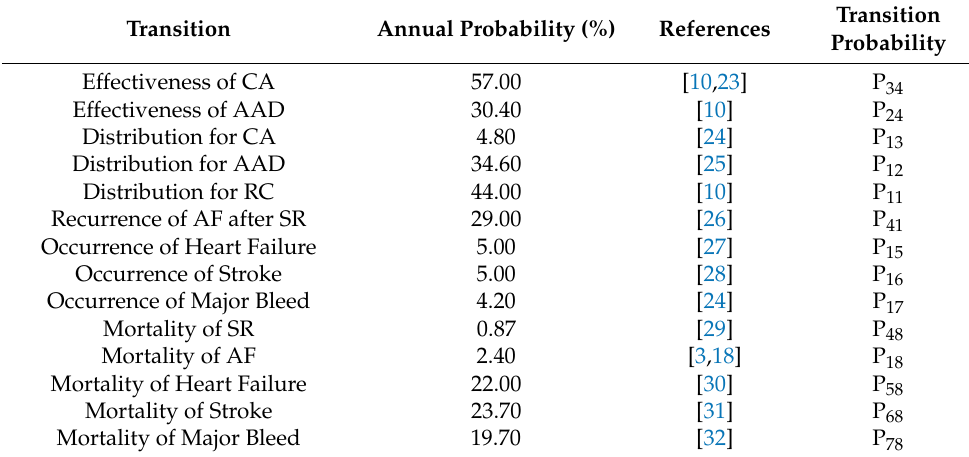
Table 1. Transition probabilities of the